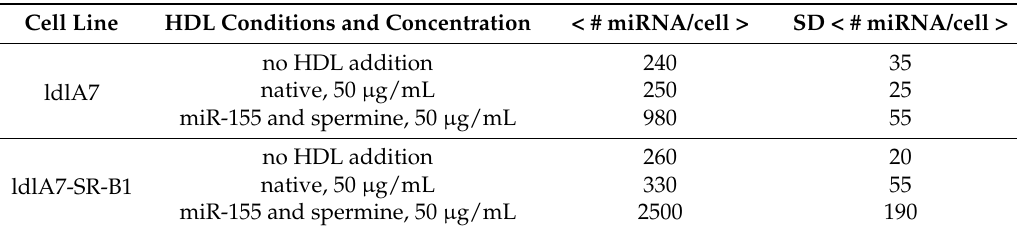
Table 4. * Influence of lipoprotein receptor density on cellular miRNA-content before/after HDL particle uptake.